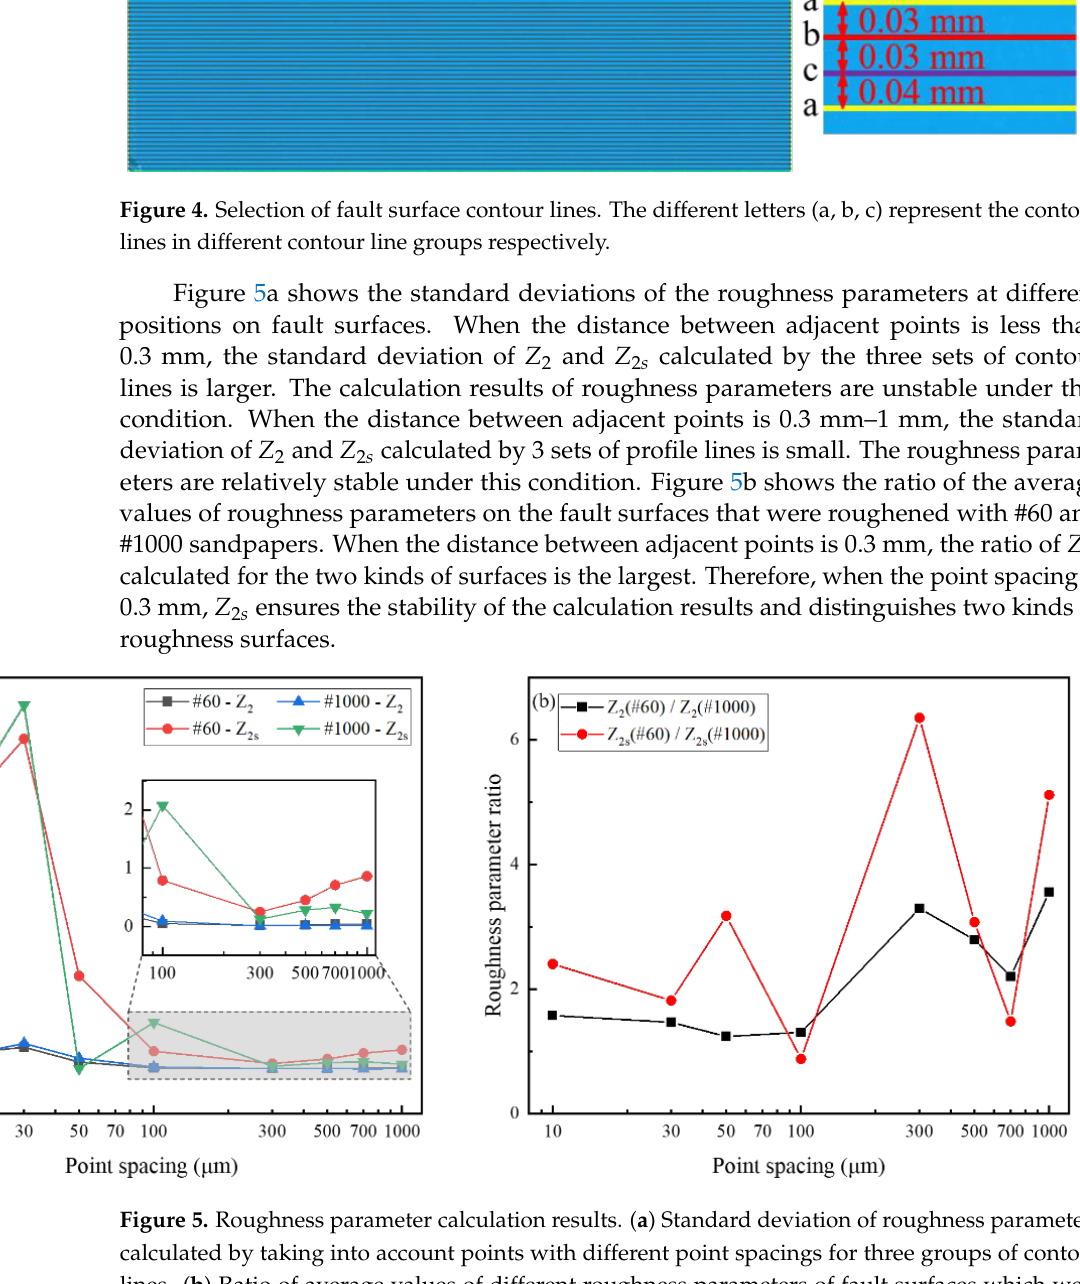
Figure 4. Selection of fault surface contour lines. The different letters (a, b, c) represent the contour lines in different contour line groups respectively.